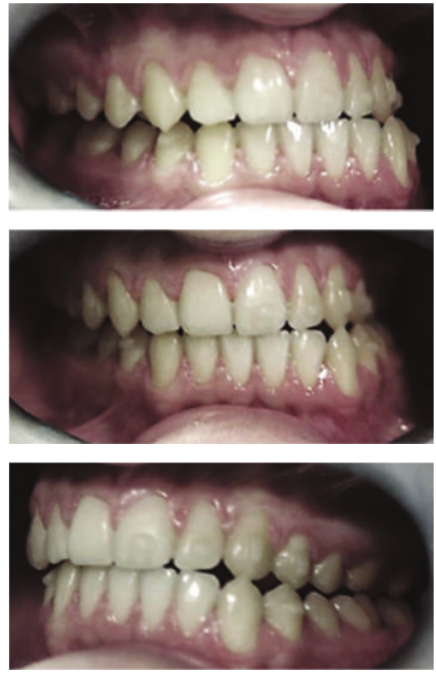
Figure 7: Clinical situation at the end of the orthodontic